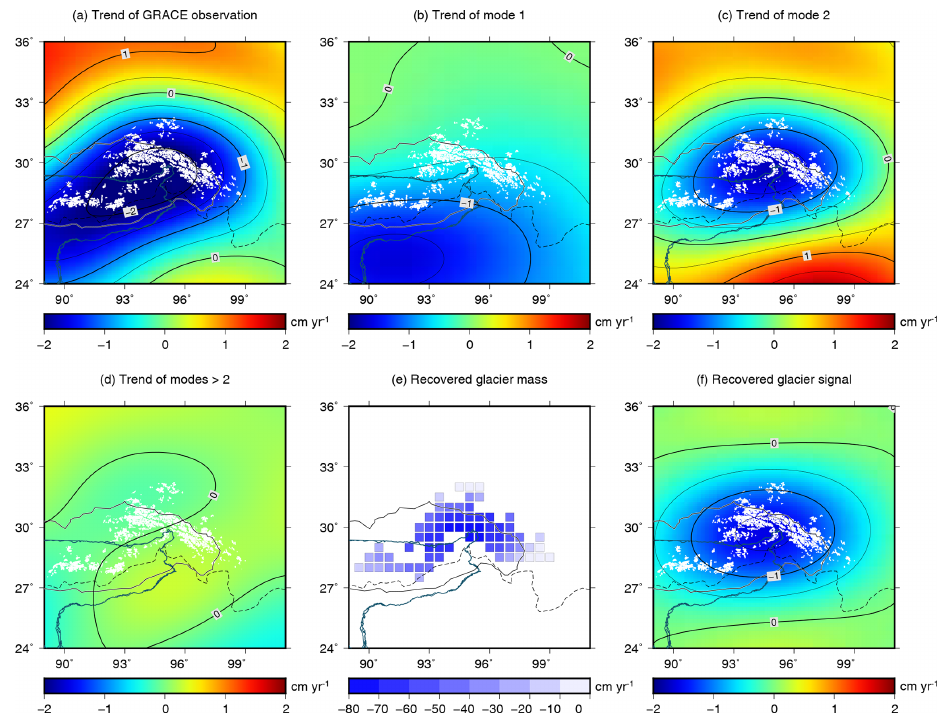
Figure 4. Trend of GRACE signals and the GS mass estimation. The CSR product with the DDK4 filter is used here. (a) The trend of GRACE EWH observations between August 2002 and June 2017 is decomposed into (b) , (c) and (d) . Using the mass changes shown in (e) , we obtained (f) by the forward-modelling method to reproduce (c) . The white shaded areas represent glacier distribution. The solid black curve marks the basin boundary, and the dashed curve marks the plateau